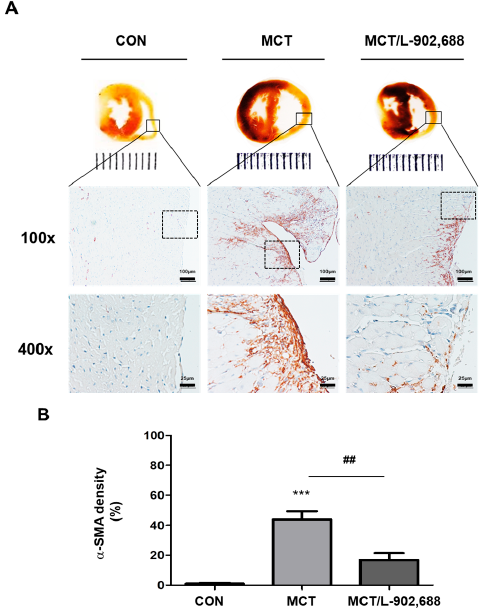
Figure 5. Histological analysis of the mesenchymal cell marker α -SMA in right ventricular (RV) tissue. ( A ) Cardiac morphology in cardiac cross-sections and histological analysis of α -SMA expression in RV tissue demonstrated that endocardial α -SMA (brown) expression was significantly higher in MCT rats at Week 4 than in control (CON) rats. However, 3 weeks of EP4 agonist 1 µg/kg/day (MCT/L-902,688) treatment significantly reduced α -SMA (brown) expression. In the top panel, scale bars = 100 µm; in the bottom panel, scale bars = 25 µm. ( B ) Quantitative analysis of α -SMA (brown) expression by a color deconvolution method demonstrated a significant reduction in the percentage of α -SMA (brown) among the total tissue area. Bars represent the mean ± SE ( n = 5 per group); *** p < 0.001 versus CON; ## p < 0.01 versus the MCT group.